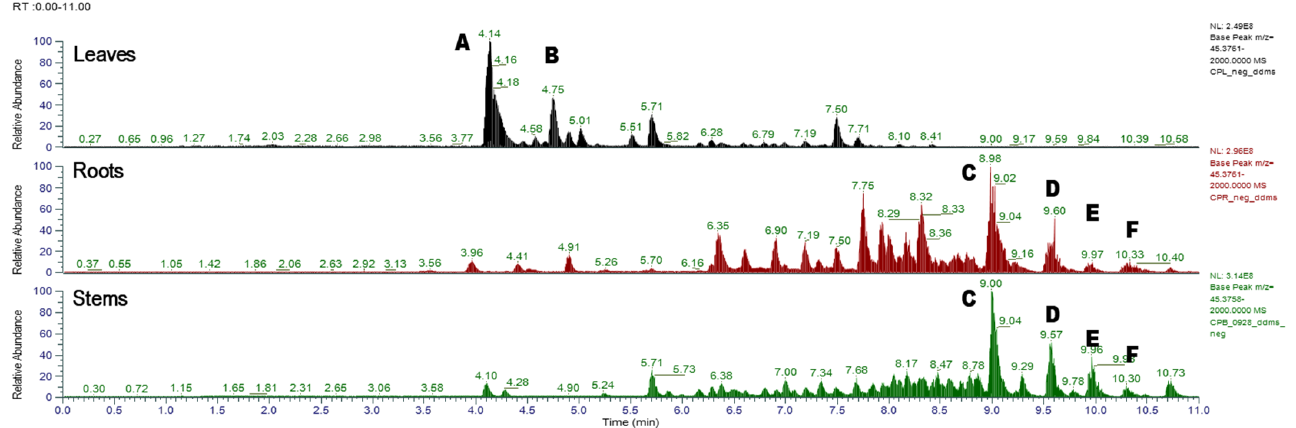
Figure 1. HRESI-MS/MS chromatograms of leaves, roots and stems of C. formosum ssp. pruniflorum.